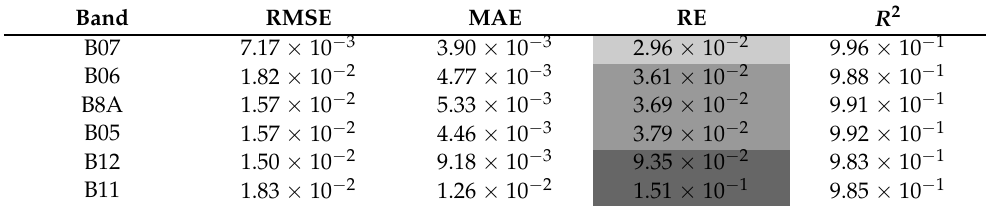
Table 3. Single-band regression results for L1C. The colors in the RE (relative error) column indicate whether the specification is fulfilled (light gray), nearly fulfilled (middle gray) or unfulfilled (dark gray).